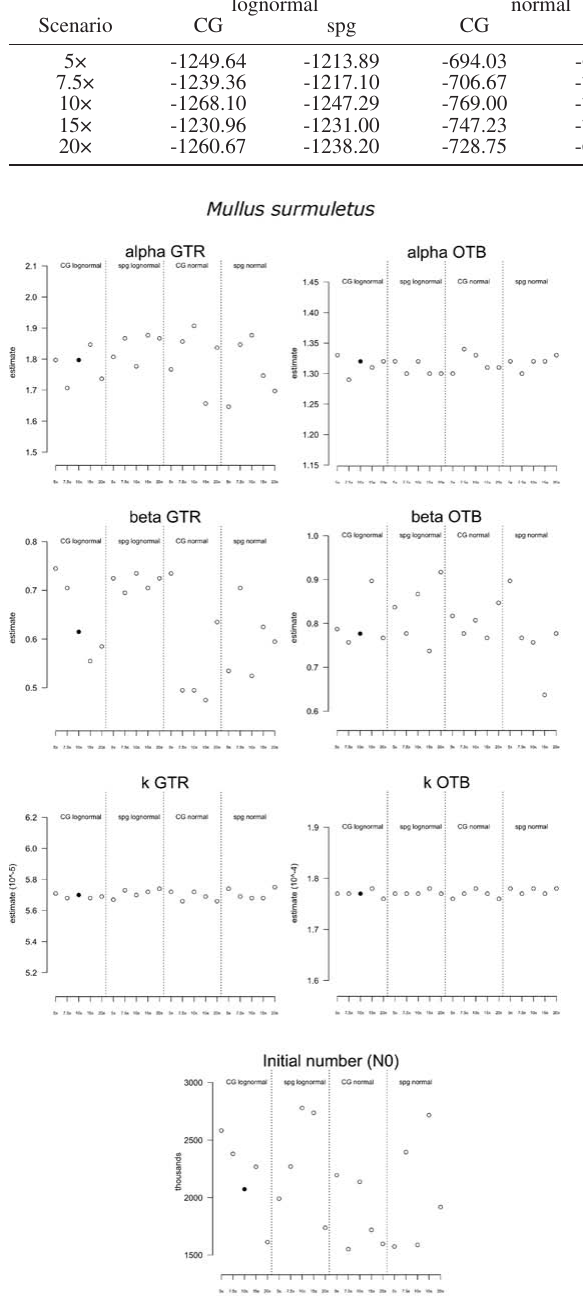
Fig. 4. – Estimates of parameters a , b , k and N for Mullus surmu- f f f 0 letus of the Vilanova i la Geltrú fishery, under different scenarios and optimization algorithms (refer to Table 1). The parameters es- timated for the model with the lowest Akaike Information Criterion are shown with filled circles.